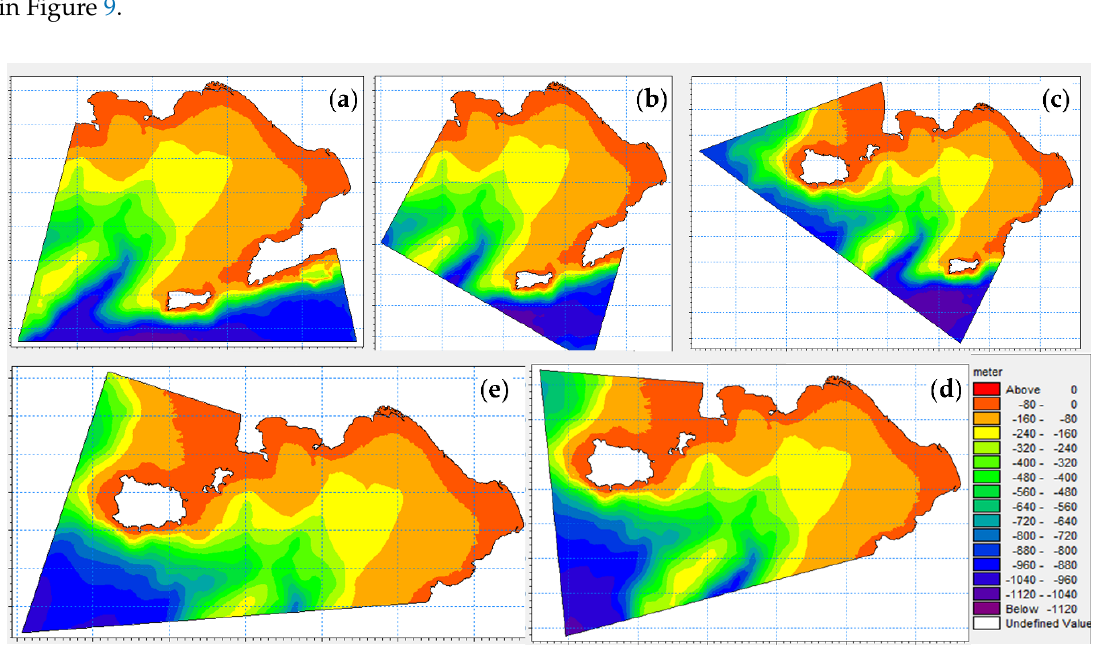
Table 8. Geographical information of nearshore study sites.